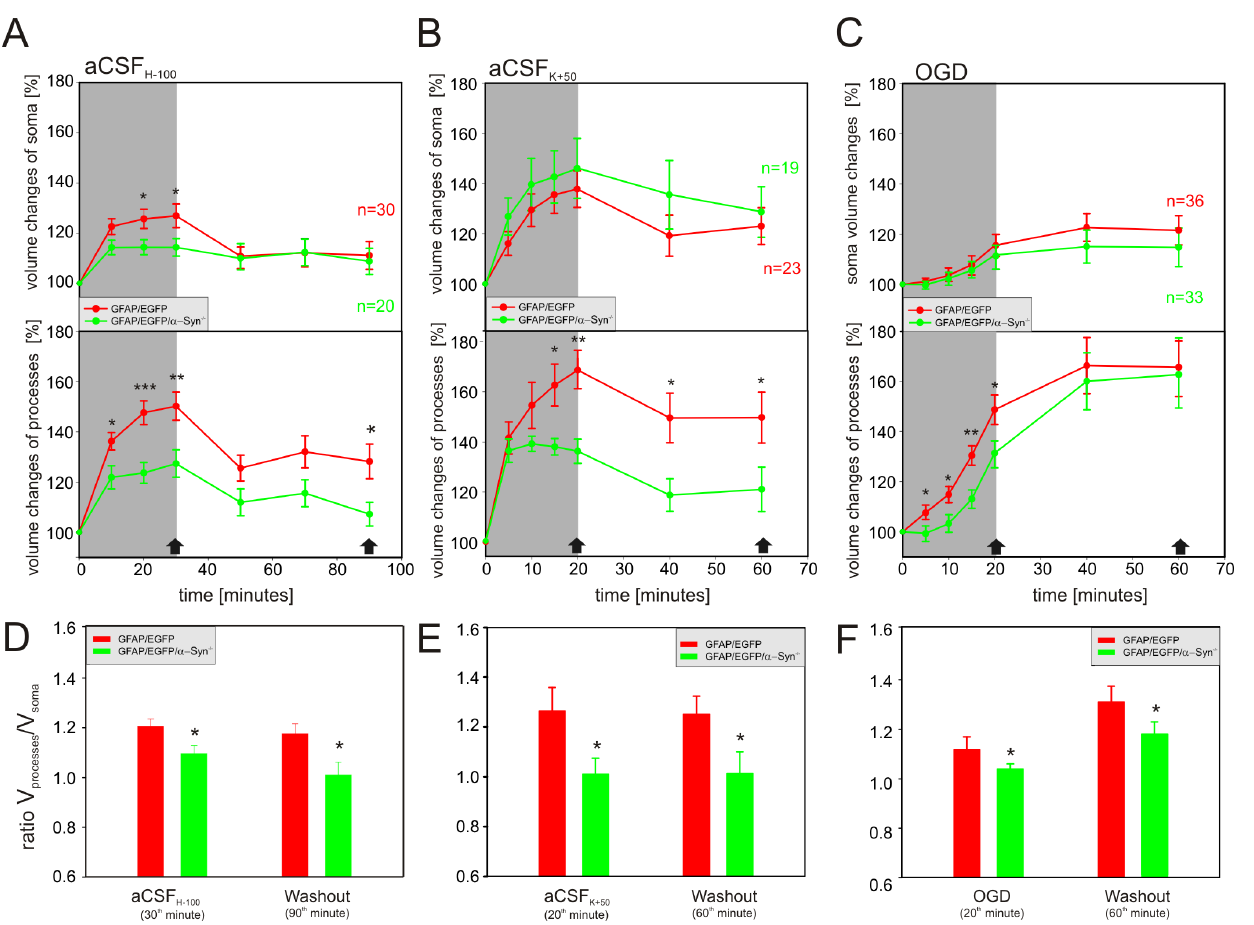
Figure 8. Volume changes in the astrocytic soma and processes during hypotonic stress, increased extracellular K + concentration and OGD. ( A– C ) Time-dependent changes in the volume of the astrocytic soma ( top ) and processes ( bottom ) in GFAP/EGFP (red) and GFAP/EGFP/ a -Syn 2 / 2 mice (green) during a 30-minute application of aCSF H-100 ( A ), a 20-minute application of aCSF K + 50 ( B ) or 20-minute OGD ( C ), followed by a 60- or 40-minute washout. ( D–F ) The contribution of the astrocytic soma and processes to the total astrocyte volume changes was expressed as a ratio of the volume changes of both compartments (V processes /V soma ) after 30 minutes of hypotonic stress and a subsequent 60-minute washout ( D ), after a 20-minute exposure to aCSF K + 50 and a subsequent 40-minute washout ( E ), and after 20 minutes of OGD and a subsequent 40-minute washout ( F ). Note that in GFAP/EGFP mice the swelling of the astrocytic processes prevails (V processes /V soma 5 , 1.2), while in GFAP/EGFP/ a -Syn 2 / 2 the ratio declines towards 1, indicating that the astrocytic processes swell less and the contribution of the cell soma to total astrocyte volume increases. The time-points at which the ratio was calculated are indicated by arrows in A–C. Asterisks indicate significant (*, p , 0.05), very significant (**, p , 0.01) and extremely significant (***, p , 0.001) differences between GFAP/EGFP and GFAP/EGFP/ a -Syn 2 / 2